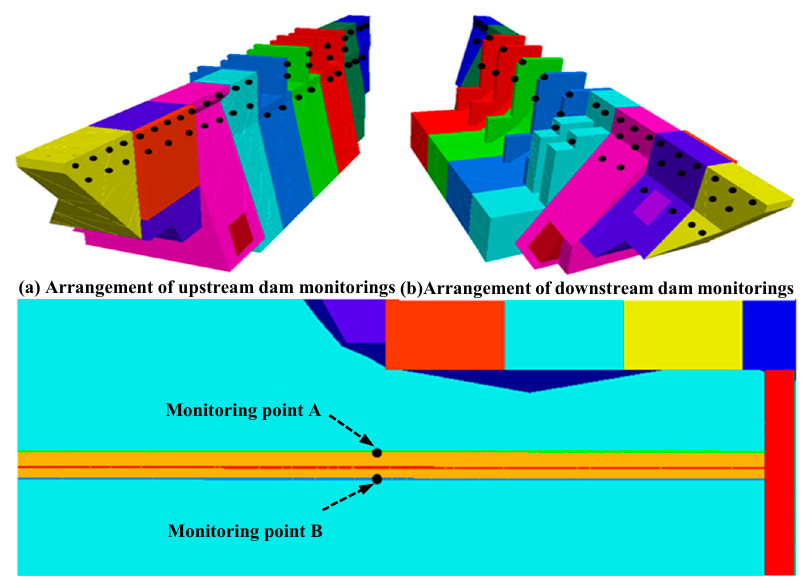
Figure 5. Layout diagrams of upstream and downstream Capulin San Pablo dam sites and monitoring points A and B.